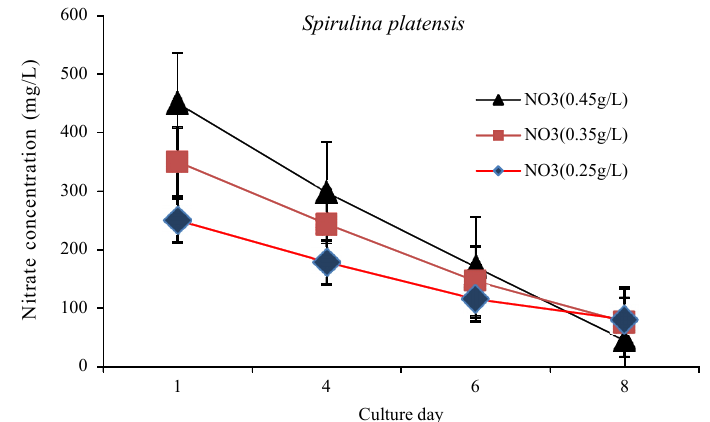
Fig. 2: Comparing the mean and standard deviation of remaining nitrate